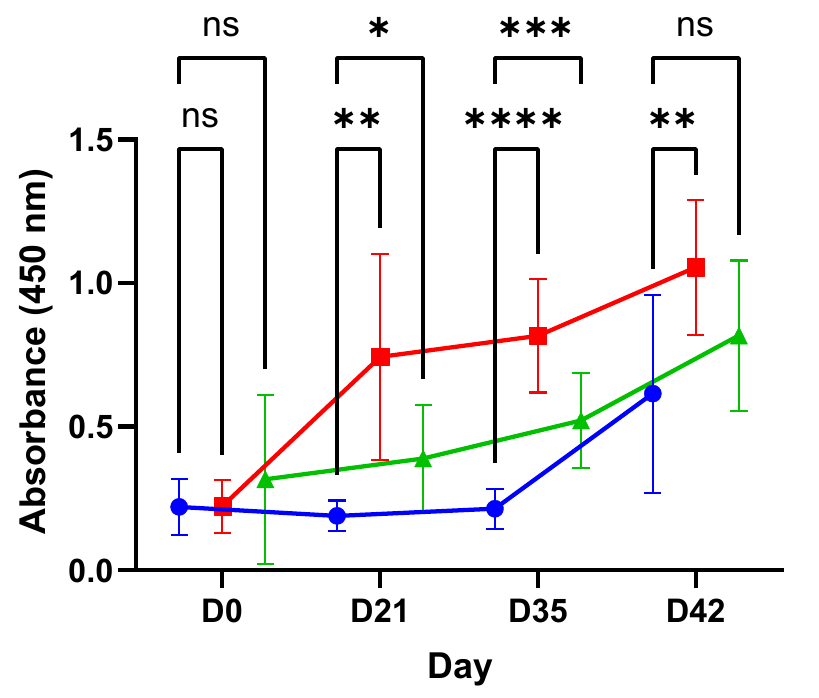
Figure 5. ELISA detection of porcine anti-cCPS antibodies (IgG). Total levels of CPS-specific IgG in pig serum. ELISA plates were coated with S. suis serotype 2 capsular polysaccharide and incubated with pig serum (dilution 1:100). IgG levels were measured for CPS-OVA, CPS-CRM197 and control (not vaccinated) groups (n = 10 each) on the day of vaccination (D0), the day of revaccination (D21), the day of infection (D35) and at the end of the experiment (D42) at 450 nm. In comparison to the control group, there was a significantly higher response in CPS-OVA (**, p ≤ 0.01) and CPS-CRM197 (*, p ≤ 0.05) groups on D21. There was also a significant response in CPS-OVA (****, p ≤ 0.0001) and CPS-CRM197 (***, p ≤ 0.001) groups on D35. On D42, the only significant difference ( p ≤ 0.01) from the control group was observed in the CPS OVA group.